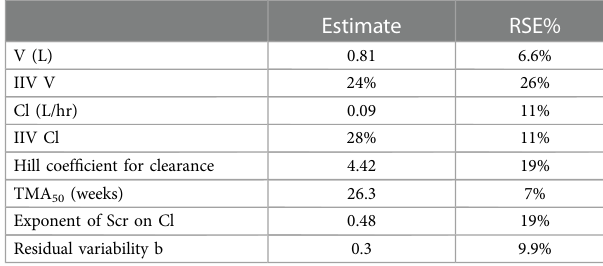
TABLE 3 Pharmacokinetic estimates for the fi nal population pharmacokinetic model.